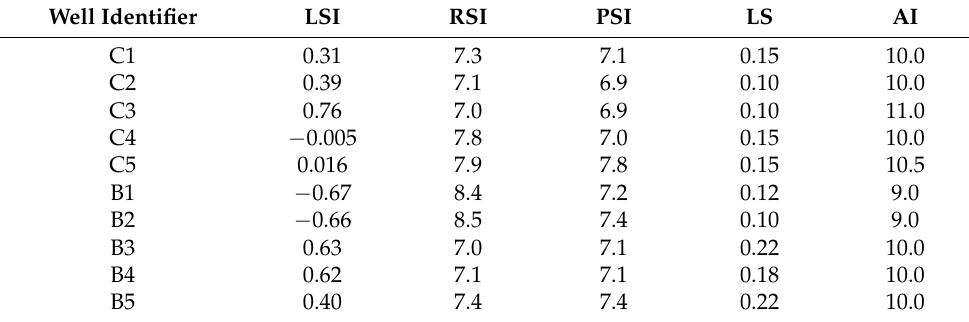
Table 4. Saturation indexes for the groundwater extraction